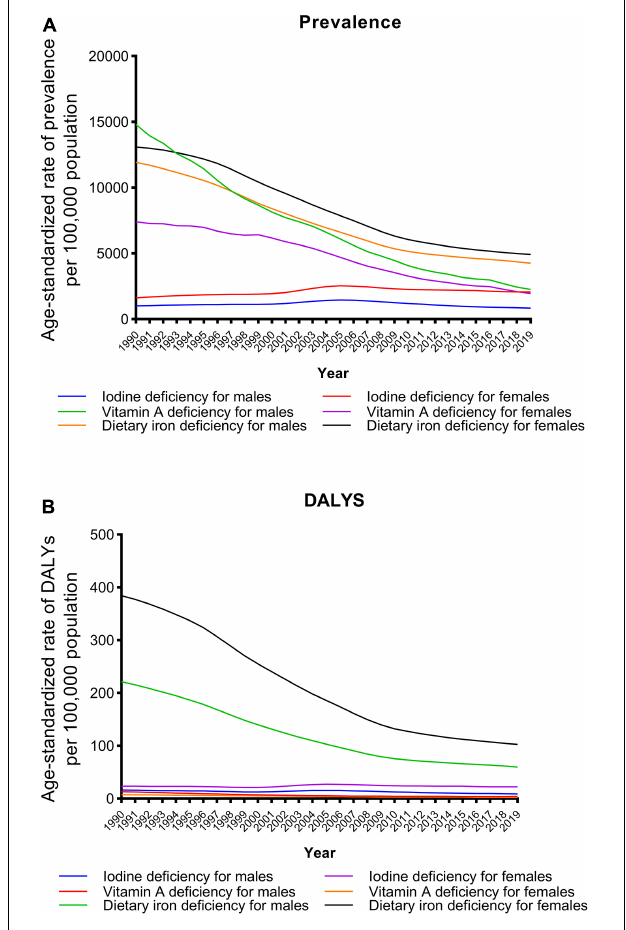
FIGURE 1 | Trends in the age-standardized prevalence (A) and DALY (B) rates of iodine deficiency, vitamin A deficiency and dietary iron deficiency by sex from 1990 to